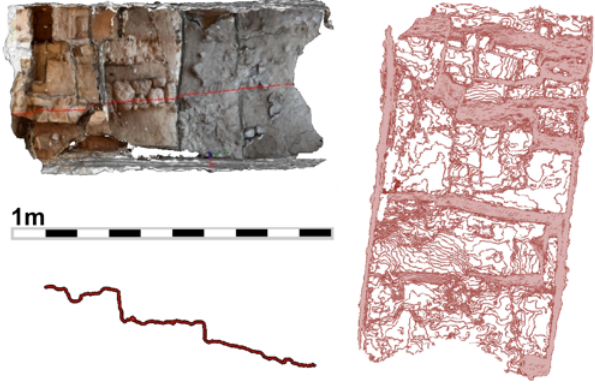
Figure 5: intermediate state of the excavation and representation extracted from photogrammetric data. Top left: Textured mesh, bottom left section following red axe on mesh, right contour